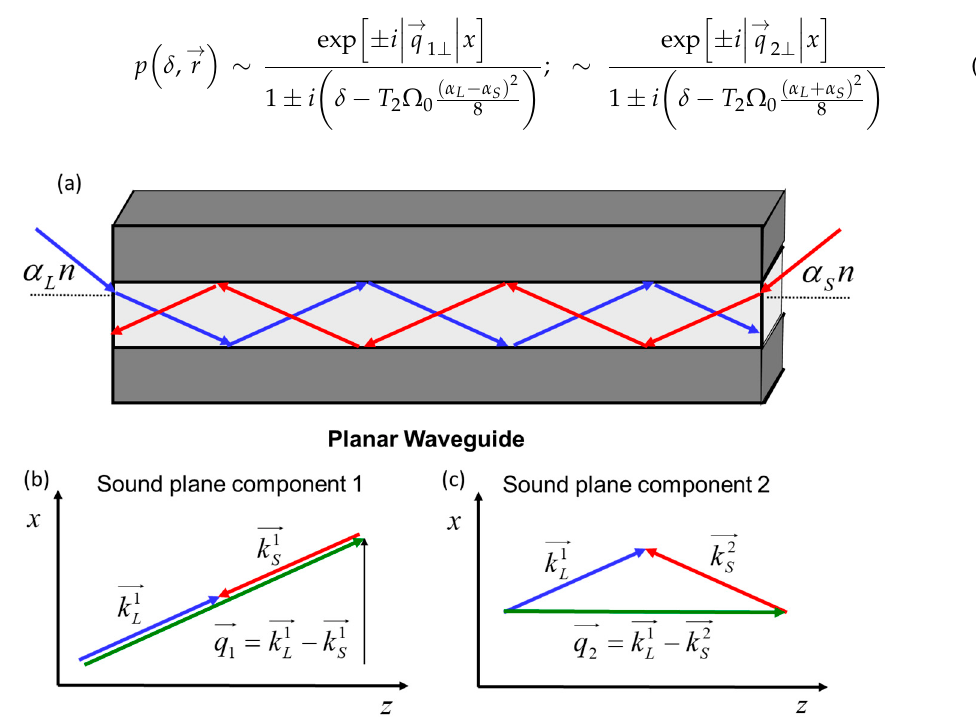
Figure 4. Brillouin interaction between eigen optical modes in a planar waveguide ( a ). Each optical mode is a combination of two plane waves, resulting in two kinds of sound plane waves possessing low ( b ) and high ( c ) spatial modulation frequencies in the waveguide cross-section.